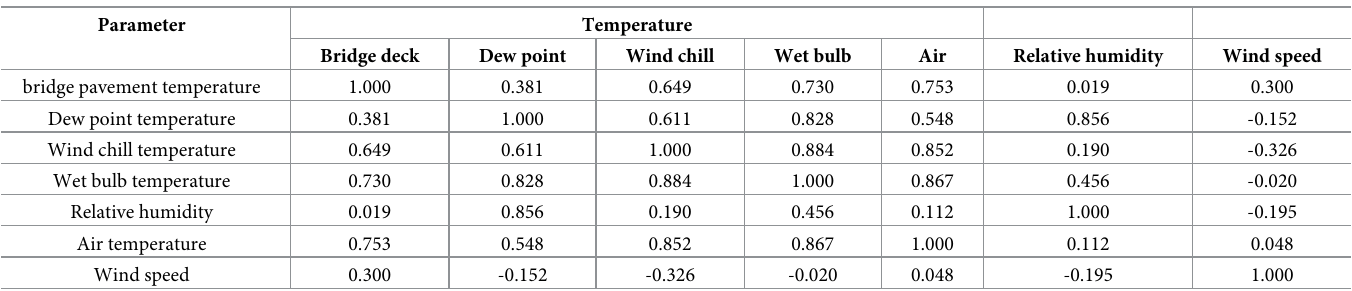
Table 4. Pearson partial correlation analysis